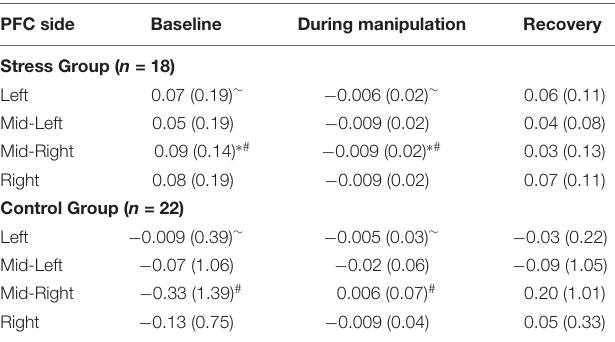
TABLE 2 | Mean values and SDs (in parentheses) for oxyHb in each of the three windows across all participants, per group (Stress and Control). PFC side Baseline During manipulation